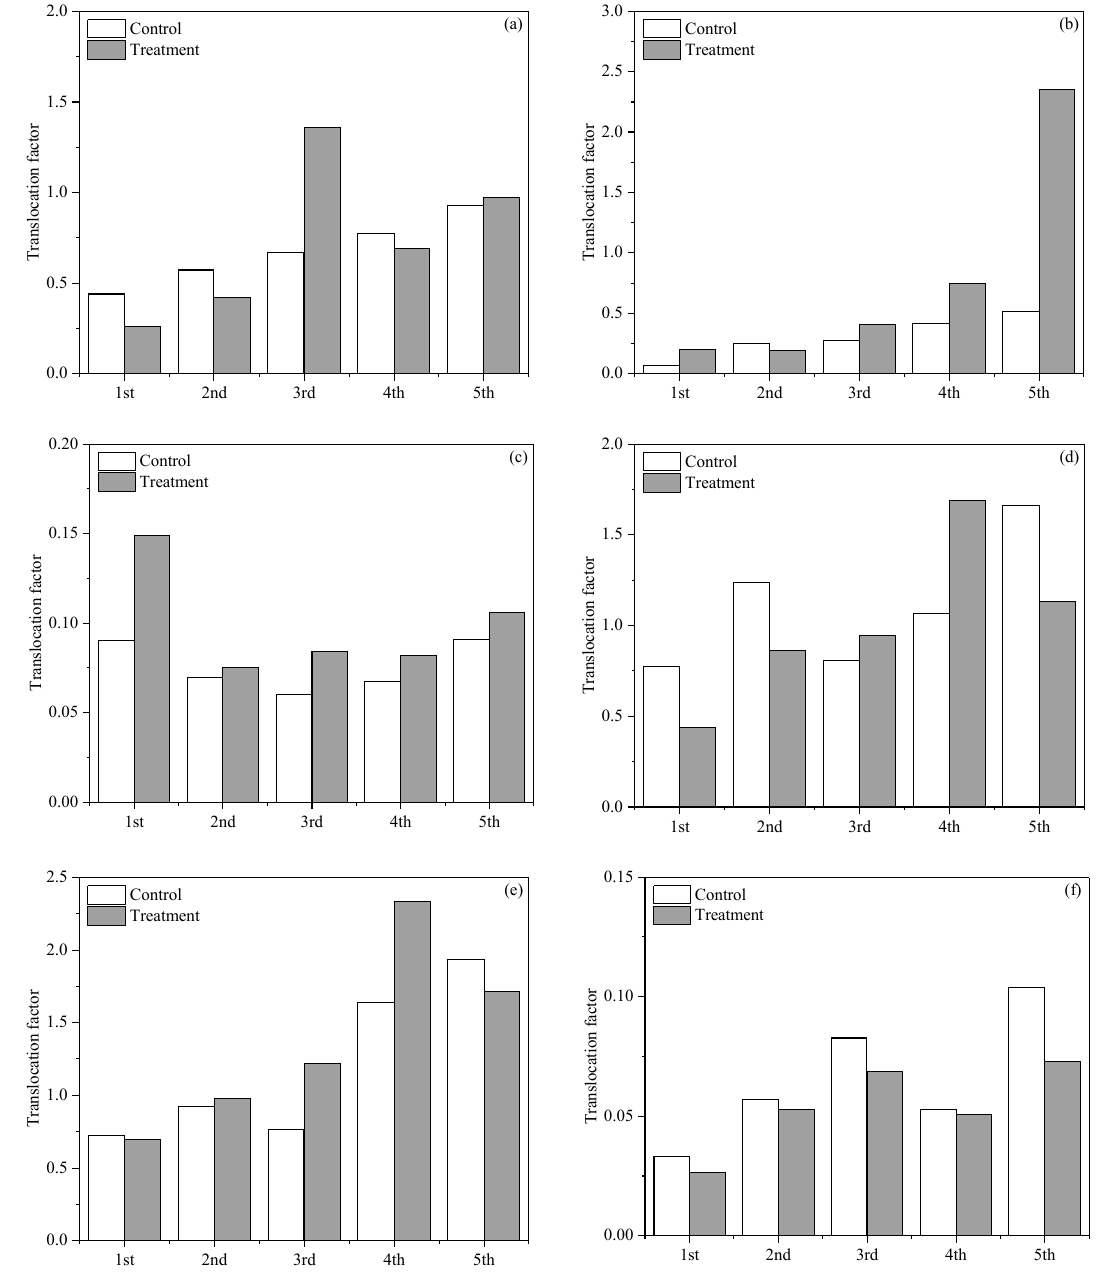
Figure 3. Translocation factor (TF) of Cr ( a ), Ni ( b ), Cu ( c ), Zn ( d ), Cd ( e ), and Pb ( f ) for the Gynura cusimbua at different harvest times